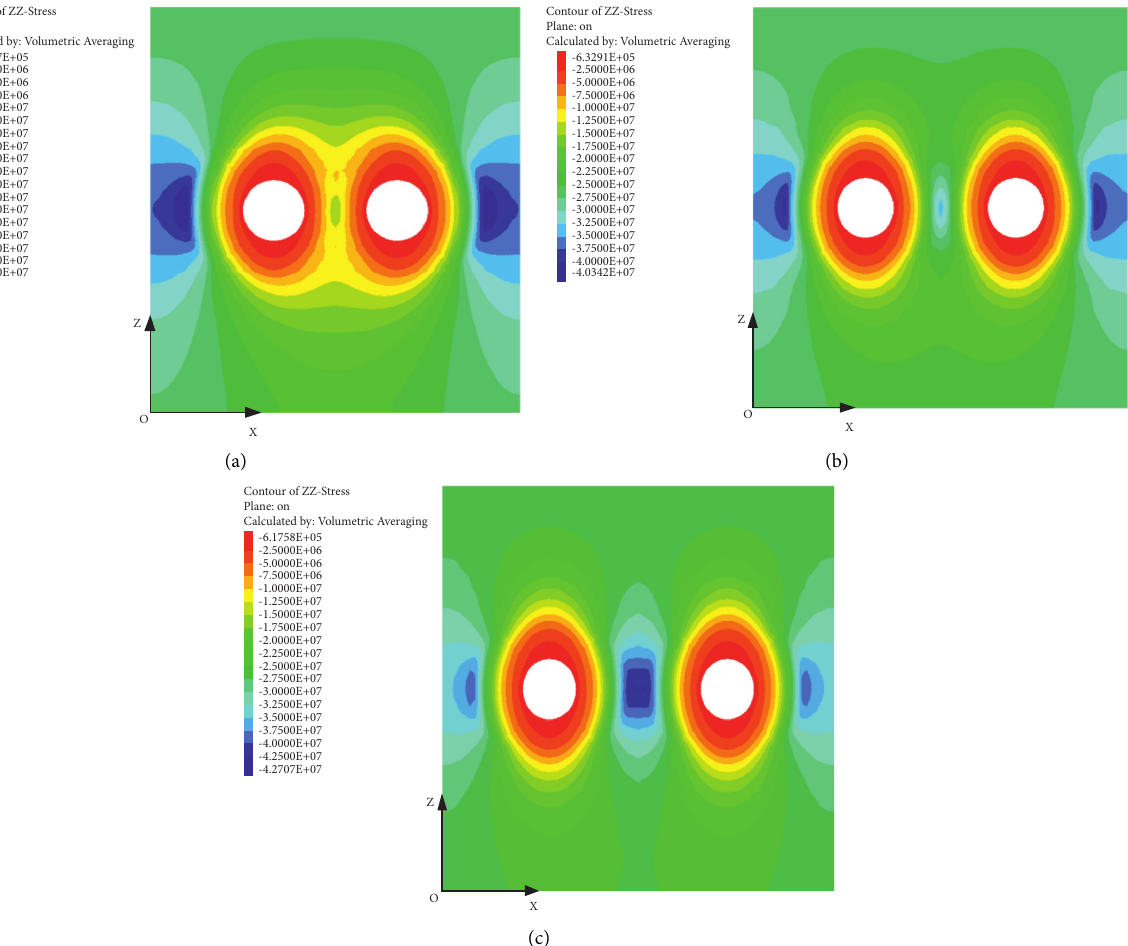
Figure 15: Contour map of vertical stress around slots with different spacings in Section 1. (a) 3.0m. (b) 4.0m. (c) 5.0m.